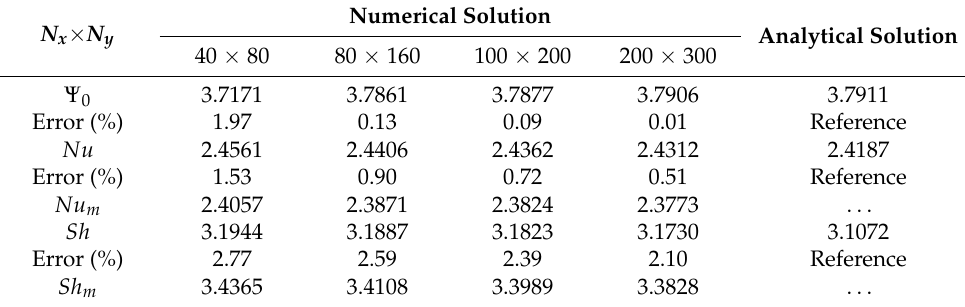
Table 1. Grid sensitivity study for A = 10, Da e = 1, R T = 10 4 , Le = 10, and D u = S r =